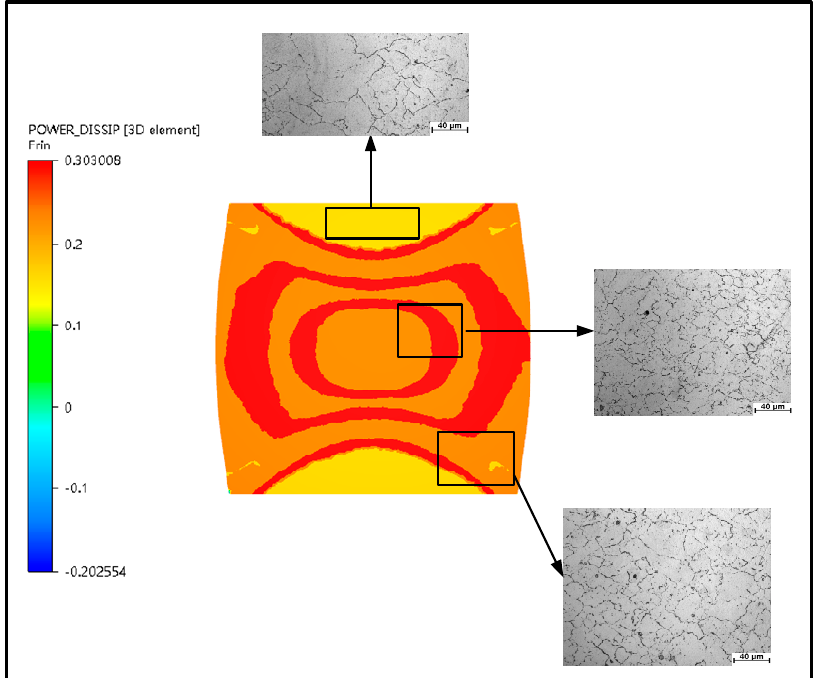
Figure 20. Characteristic diagram of thermal deformation power dissipation at 1050 °C/0.3/0.1 s − 1 .